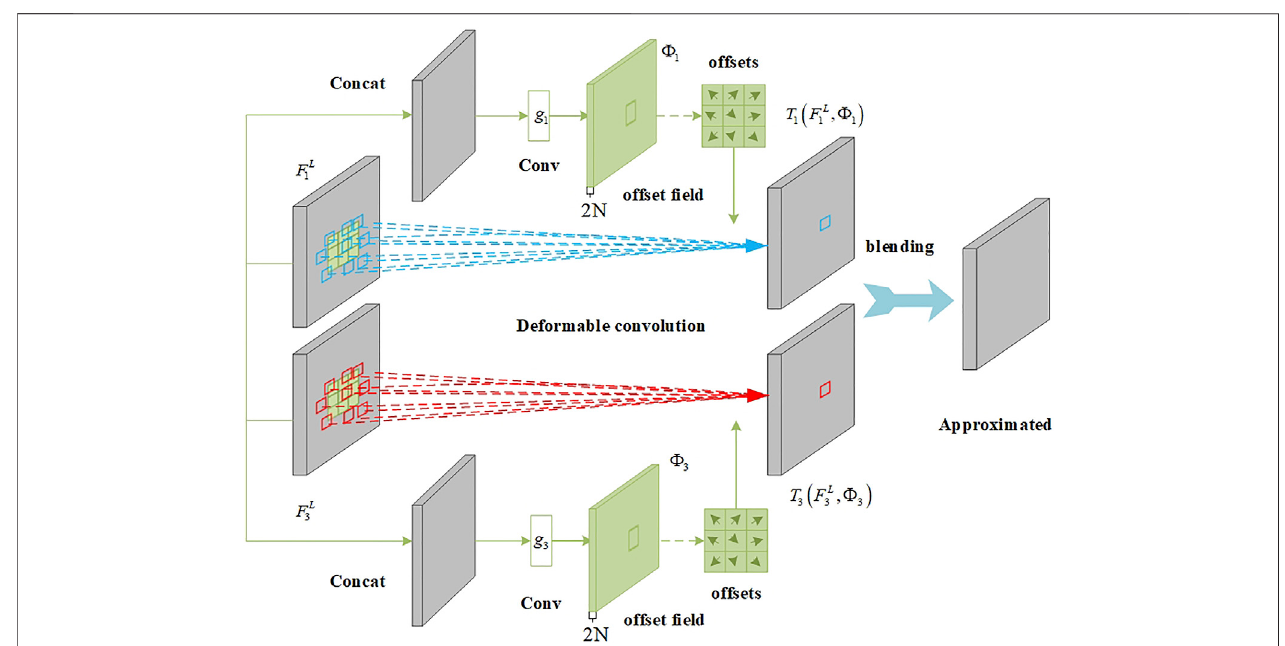
FIGURE 2 | Frame feature time interpolation